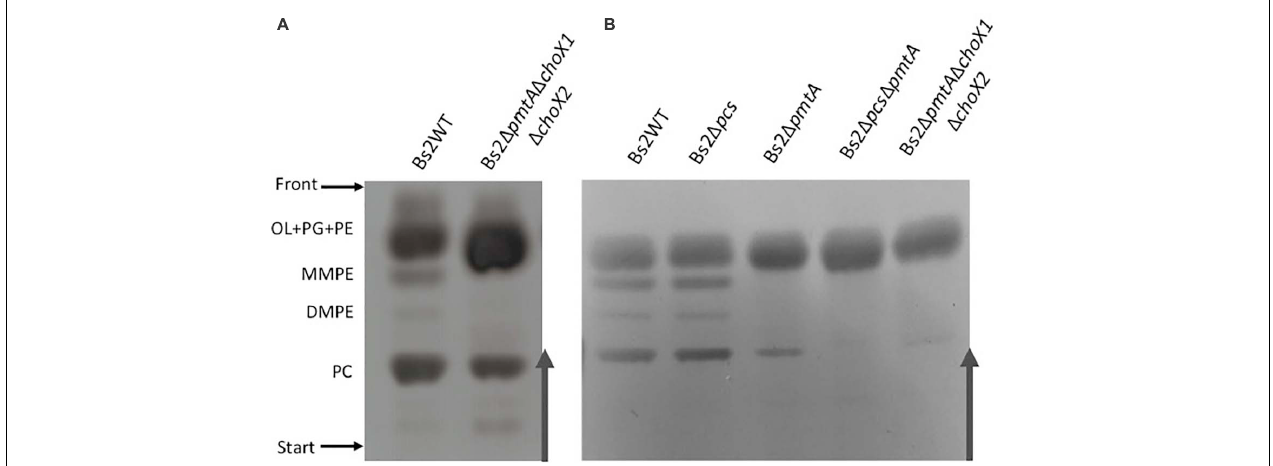
FIGURE 5 | High-performance thin-layer chromatography analysis of the free lipids of Bs2WT- and Bs2-derived (A) mutants grown in TSB and (B) mutants grown in mGSM. OL, ornithine lipids; PG, phosphatidylglycerol; PE, phosphatidylethanolamine; MMPE, monomethyl-phosphatidylethanolamine; DMPE,